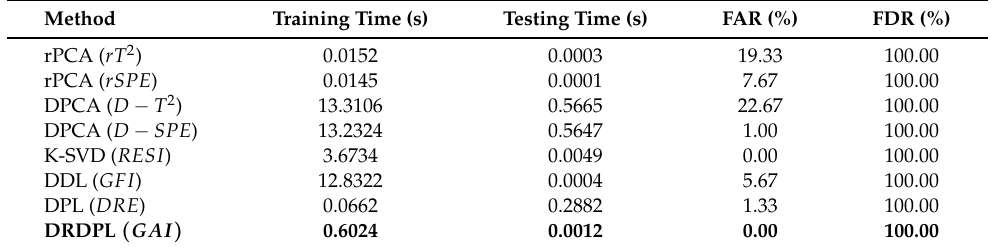
Table 6. The comparison results of anode effect in aluminum electrolysis process.